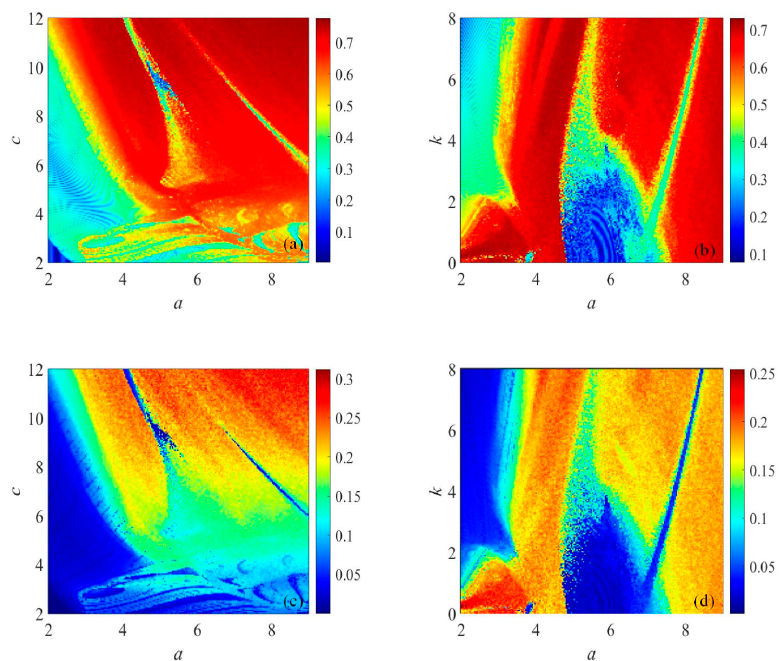
Figure 9. Initial conditions (1, 1, 1, 1, 1, 1) with b = 0.01, d = 31, e = 5, g = 0.05, l = 6; ( a ) k = 7 with SE